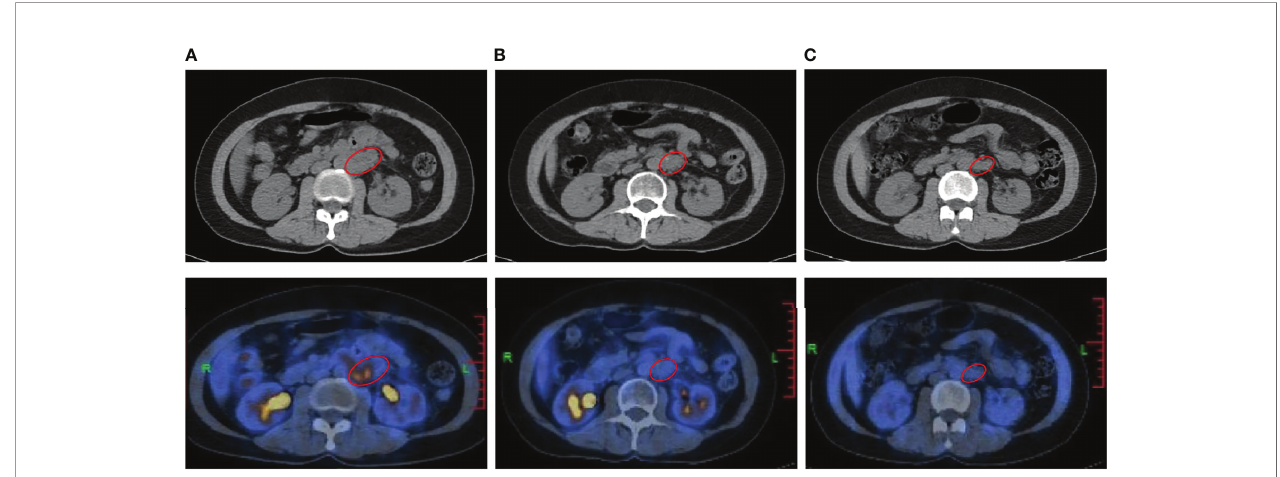
FIGURE 2 | Radiological imaging of the patient before and after the combination treatment of camrelizumab and apatinib. (A) 18 F-FDG positron emission tomography (PET)/CT performed on October 23, 2019, showing recurrence before treatment (baseline). (B, C) PET/CT performed on October 9, 2020 (B) and November 16, 2021 (C) showing the reduced tumor size and SUVmax at 12 months and 25 months after the initiation of treatment, respectively. The red circle indicates the